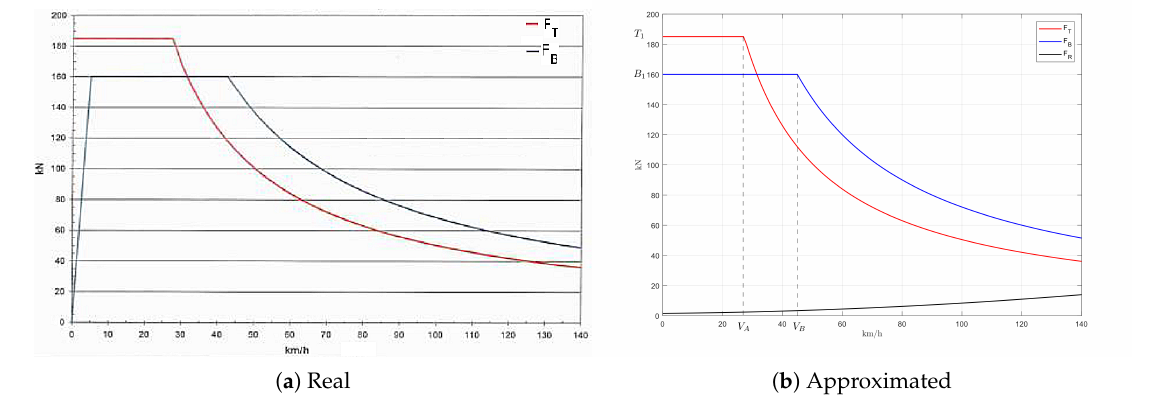
Figure 3. Train traction and braking forces vs. train